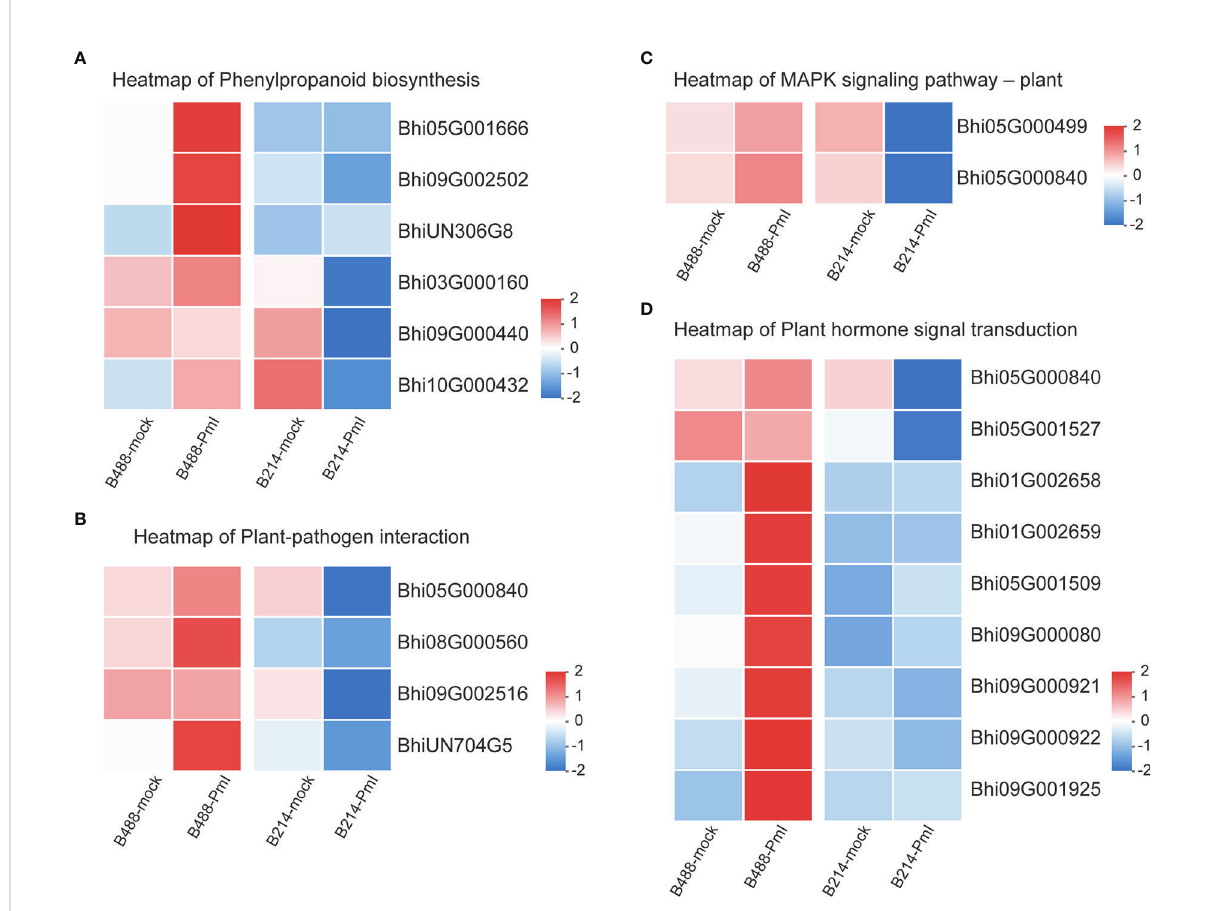
FIGURE 5 Heatmap of DEGs. (A) Heatmap of the DEGs in the phenylpropanoid biosynthesis pathway. (B) Heatmap of the DEGs in the plant pathogen interaction pathway. (C) Heatmap of the DEGs in the MAPK signaling-plant pathway. (D) Heatmap of the DEGs in the plant hormone signal transduction pathway. Log 10 (FPKM+1) values were used in the heatmap, and the average values of FPKM from the three biological replicates were used for log 10 (FPKM+1) calculation. Red indicates high expression, and blue indicates low